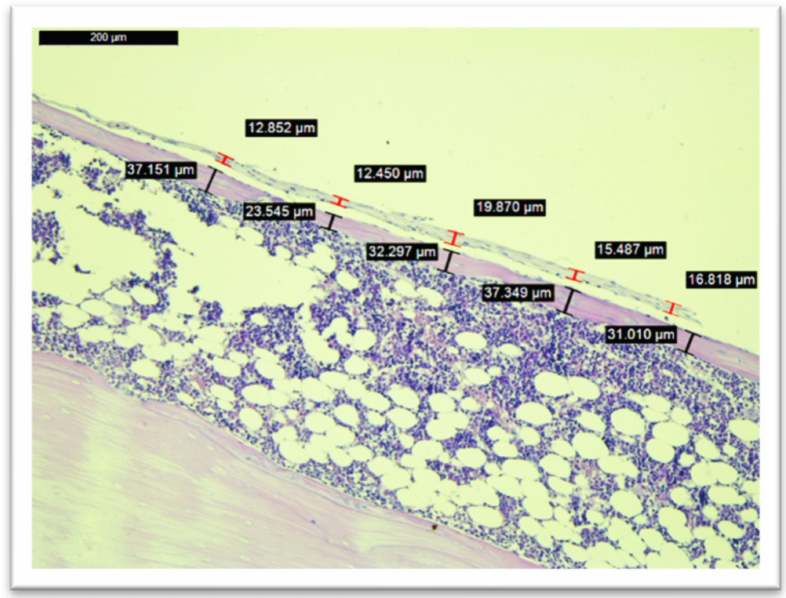
Figure 6. Histological measurements of cortical bone tissue and fibrous tissue in the peri-implant site within Group I (control).